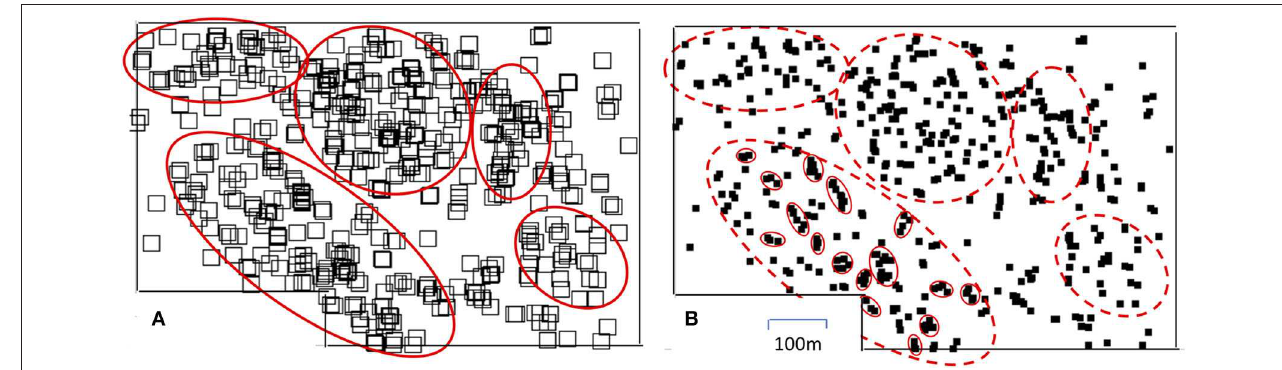
FIGURE 4 | The distribution of nests of the tree-nesting ant species Azteca sericeasur on an organic coffee farm in Chiapas Mexico, in year 2016. (A) Position of nests represented by large squares to suggest the large scale clusters existing in the system, a qualitative correspondence with the expectation from rule 126 (red ovals indicate approximate extent of the proposed five megaclusters). (B) Same positions of nests represented by small black squares revealing the substructure of each of the five megaclusters identified in a, with small ovals identifying the subclusters in the lower left megacluster.